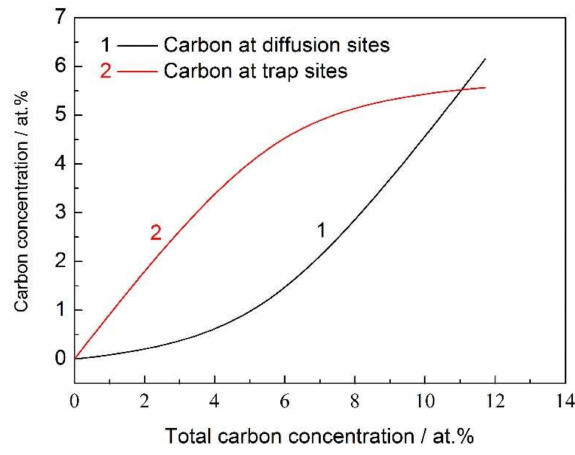
Figure 8. Carbon concentrations at the diffusion sites and the trap sites vs. total carbon